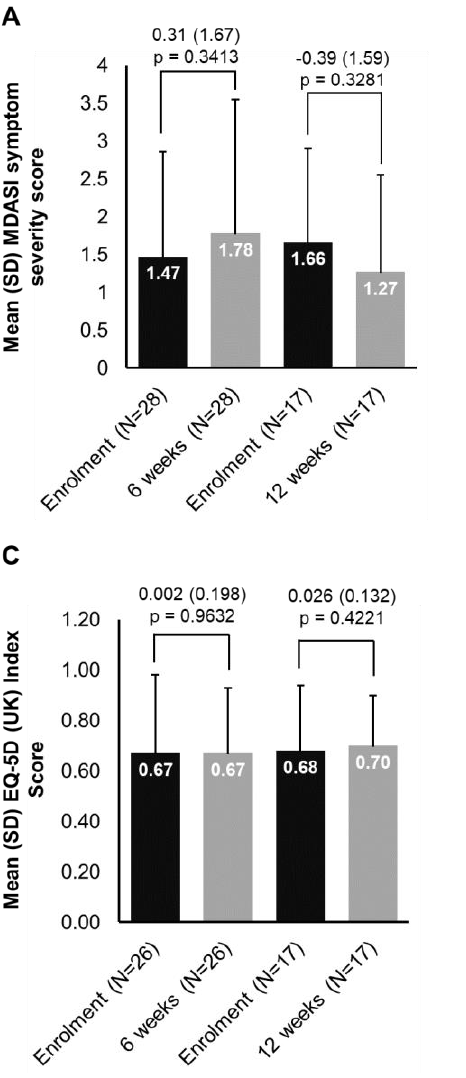
Figure 2. Changes in PROs from enrolment at week 6 and 12: ( A ) MDASI symptom severity, ( B ) MDASI interference, ( C ) EQ-5D (UK) Index, ( D ) EQ-VAS. Each of the 13 symptoms in the MDASI symptom severity scale is rated on an 11-point scale to indicate the presence and severity of the symptom in the last 24 h with 0 meaning ‘not present’ and 10 meaning ‘as bad as you can imagine’. Each of the 6 items in the MDASI symptom interference scale is rated based on the level of symptom interference with the function of a patient’s life in the last 24 h and also measured on an 11-point scale (0 = ‘did not interfere’ to 10 = ‘interfered completely’). The EQ-5D-3L descriptive system comprises 5 dimensions and each dimension is rated based on 3 levels: no problems, some problems, extreme problems. The EQ-VAS records the respondent’s self-rated health on a vertical, visual analog scale (gradated from 0–100) where the endpoints are labeled ‘Best imaginable health state’ and ‘Worst imaginable health state’ with higher scores indicating higher HRQoL.EQ-5D—EuroQoL 5-Dimensions; MDASI—M.D. Anderson Symptom Inventory; N—number of patients; PRO—patient- reported outcome; SD—standard deviation; UK—United Kingdom; VAS—Visual Analogue